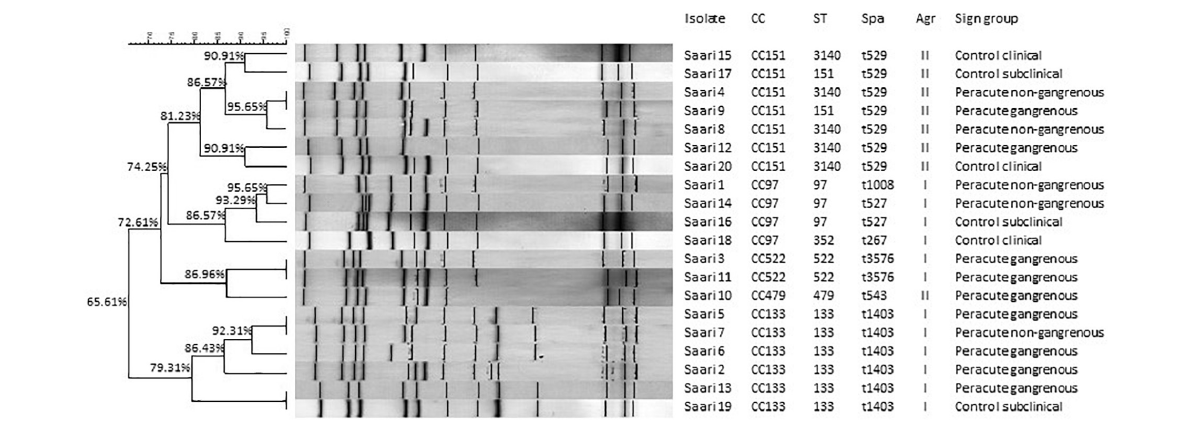
FIGURE 4 | Ribotypes, clonal complexes (CC), sequence types (ST), staphylococcal protein A types (spa), and accessory gene regulator (agr) classes of 20 Staphylococcus aureus isolates. The ribopatterns were compared, using Dice coefficient correlation. Unweighted Pair Group Method with Arithmetic mean (UPGMA) clustering was used for construction of the